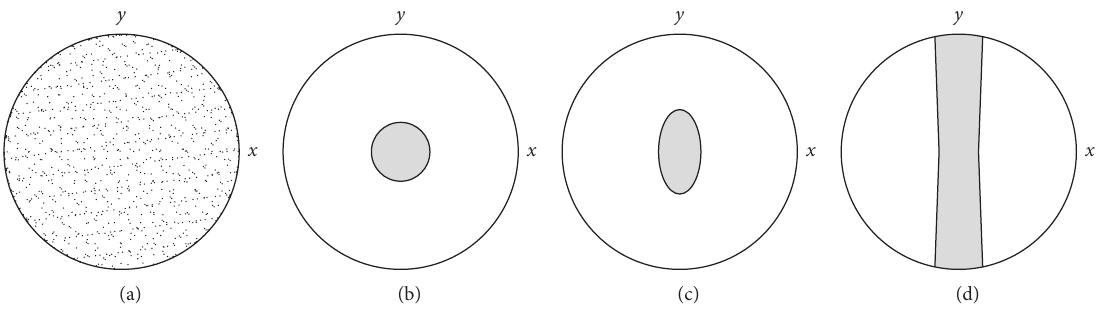
Figure 1: Schmidt diagrams demonstrate typical fabrics in the ice sheet: (a) a random ice, (b) a perfect single pole, (c) an elongated single pole, and (d) a vertical